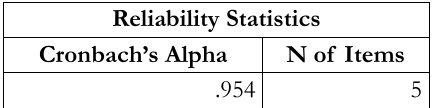
Table 10. Results of Analysis of the Validity and Reliability of Reasoning Instruments